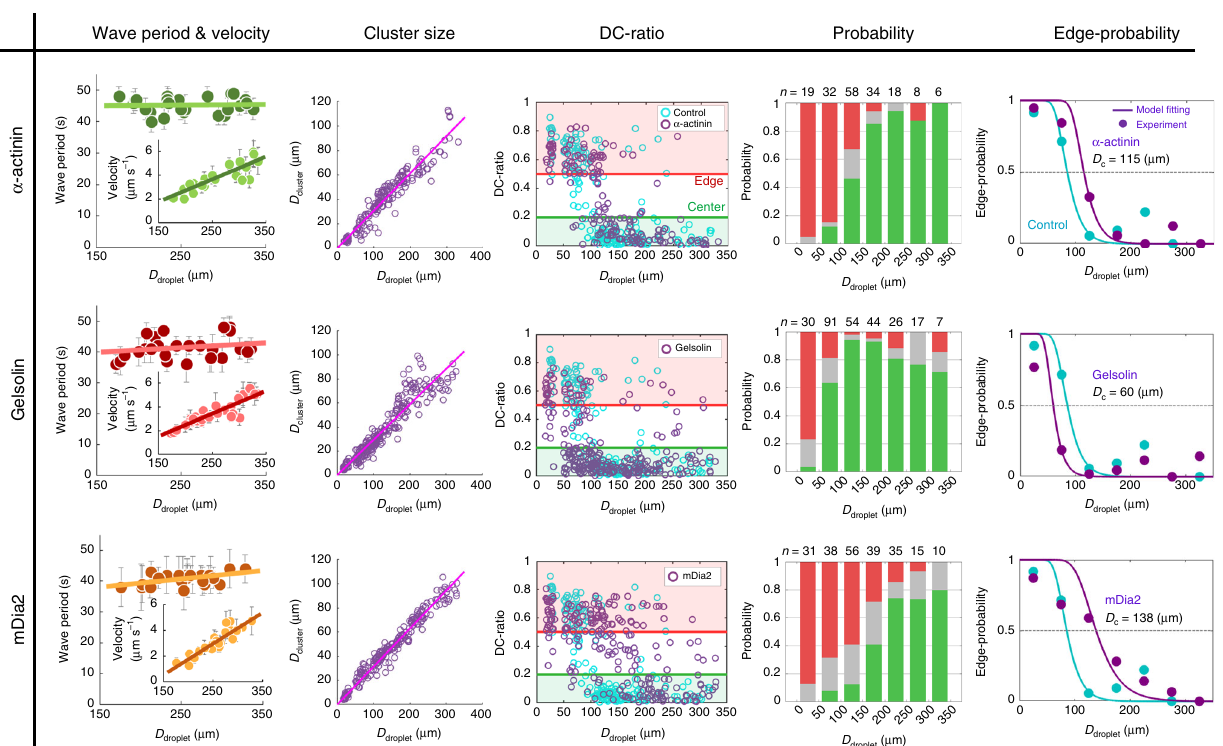
Fig. 5 Modulation of the network connectivity and F-actin length alter the cluster positioning. The connectivity and F-actin length of actomyosin networks in the bulk space were modulated by adding actin-associated proteins. Error bars displayed in the wave period and velocity represent standard deviations from the mean periods and mean velocity averaged over three successive wave periods and waves, respectively. Cyan circles in the DC-ratio show the control data. Cyan circles and curves in the Edge-probability show the control data and the model fi tting, respectively. ( Top ) Addition of the actin crosslinker, α -actinin (250nM). The wave period T and initial contraction velocity v (inset) were fi tted by T = 1.8×10 − 3 D droplet + 45 ( R 2 <0.01) and v = 1.9×10 − 2 D droplet − 1.1 ( R 2 = 0.76), respectively ( n = 25) (Supplementary Movie 15). Cluster diameter was fi tted by D cluster = 0.31 D droplet ( n = 175, R 2 = 0.91). Edge-positioned probability was fi tted by Eq. (2) using L = 6.1 μ m and τ = 0.09s. Transition diameter D c = 115 μ m. (Middle) Addition of the actin severing protein, gelsolin (300nM). The wave period T and initial contraction velocity v were fi tted by T = 1.5×10 − 2 D droplet + 38 ( R 2 = 0.04) and v = 1.9×10 − 2 D droplet − 1.4 ( R 2 = 0.81), respectively ( n = 27) (Supplementary Movie 16). The cluster diameter was fi tted by D cluster = 0.29 D droplet ( n = 269, R 2 = 0.89). Edge-positioned probability was fi tted by Eq. (2) using L = 4.3 μ m and τ = 0.46s. Transition diameter D = 60 μ m. (Bottom) Addition of actin polymerization activator, mDia2 (30nM). The c wave period T and initial contraction velocity v were fi tted by T = 2.7×10 − 2 D droplet + 34 ( R 2 = 0.26) and v = 2.4×10 − 2 D droplet − 3.1 ( R 2 = 0.83), respectively ( n = 27) (Supplementary Movie 17). The cluster diameter was fi tted by D cluster = 0.31 D droplet ( n = 224, R 2 = 0.96). Edge-positioned probability was fi tted by Eq. (2) using L = 10 μ m and τ = 0.46s. Transition diameter D c = 138 μ m. We con fi rmed that addition of actin-associated proteins had little in fl uence on the cluster size distribution compared to the control experiments (Fig. 1h). Kolmogorov – Smirnov test was applied to the scatter plots of DC-ratio between D droplet = 50 µ m – 150 µ m (around the transition point in the control experiment). The distributions were signi fi cantly different from the control in all conditions ( p <0.01). We performed two independent